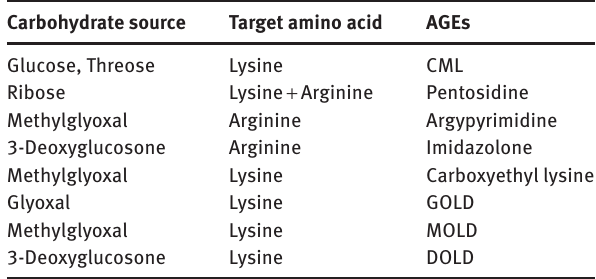
Table 1: Commonly found AGEs in biological systems and corre- sponding carbohydrate source and target amino